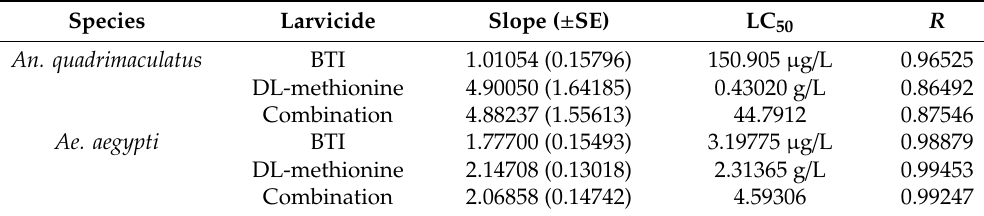
Table 2. Concentration response analysis of DL-methionine, Bacillus thuringiensis subspecies israelensis (BTI), and their combination on Anopheles quadrimaculatus (n = 4) and Aedes aegypti (n = 6) exposed for 48 h in glass jars. Slopes of the median e ff ects plots with standard errors and lethal concentrations to 50% mortality (LC 50 ) for the combination experiment. Calculated using the software Compusyn [30]. See Supplementary Materials (Tables S4 and S5) for mortality